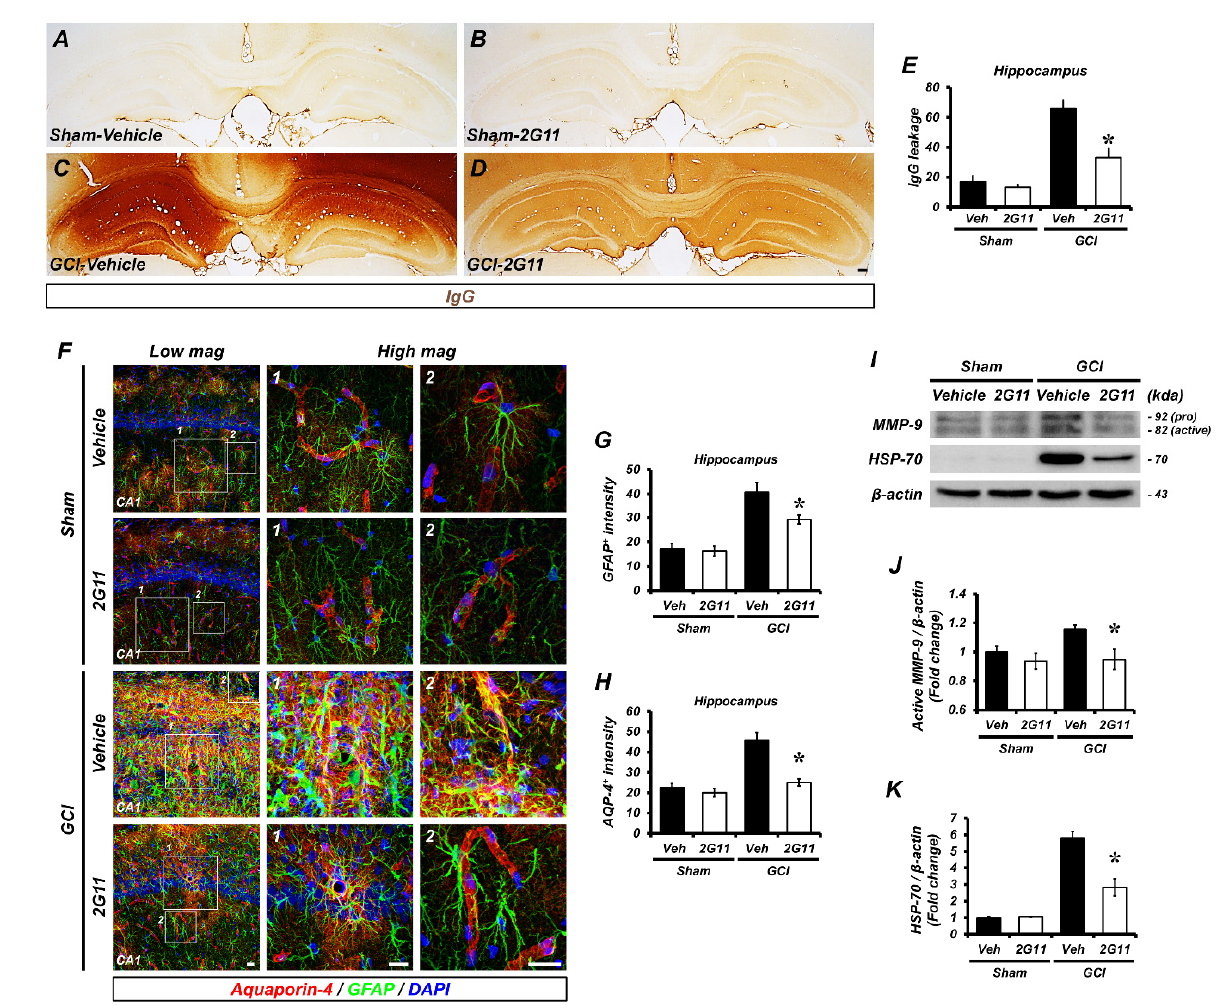
Figure 5. The 2G11 treatment reduced BBB disruption and MMP-9 activation after GCI. ( A – D ) Pho- tomicrographs showing sections of the hippocampus stained for IgG from the vehicle-treated sham, 2G11-treated sham, vehicle-treated GCI, and 2G11-treated GCI groups 3 days after the sham surgery or GCI. Scale bar = 100 μ m. ( E ) Graph representing IgG leakage from the hippocampus in rats treated with the vehicle or 2G11 3 days after the sham surgery or GCI. Data are the mean ± SEM; n = 6. * p < 0.05 vs. the vehicle-treated GCI group (Kruskal–Wallis test followed by a Bonferroni post-hoc test; chi square = 14.184, df = 3, p = 0.003). ( F ) Representative images showing BBB marker SMI-71 + endothelial protein co-labeled with the reactive astrocyte marker GFAP and the water channel protein marker AQP4 in the hippocampal CA1 from vehicle- and 2G11-treated rats 3 days after the sham surgery or GCI. Scale bar = 20 μ m. ( G , H ) Bar graphs showing the immunofluorescence intensity of GFAP and AQP4 3 days after GCI . Data are the mean ± SEM; n = 5. * p < 0.05 vs. the vehicle-treated GCI group (Kruskal–Wallis test followed by a Bonferroni post-hoc test; G: chi square = 12.156, df = 3, p = 0.007; H: chi square = 13.091, df = 3, p = 0.004). ( I ) Western blot analysis of MMP-9 in the hippocampus after the sham surgery or GCI. Quantification of MMP-9 and HSP-70 protein levels from the hippocampus. Data are the mean ± SEM; n = 4. * p < 0.05 vs. the vehicle-treated GCI group (Kruskal–Wallis test followed by a Bonferroni post-hoc test: ( J ) chi square = 7.832, df = 3, p = 0.05; ( K ) chi square = 12.217, df = 3, p =